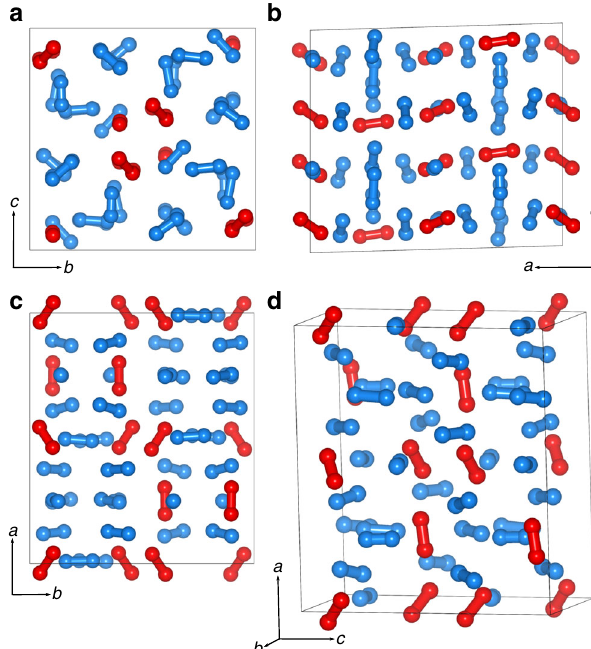
Fig. 3 The re fi ned crystal structure of ι – N 2 . a – c Projections along the a , b and c axes respectively. d A perspective projection of the unit cell. Layered N 2 molecules are shown in blue and oriented molecules are shown in red.